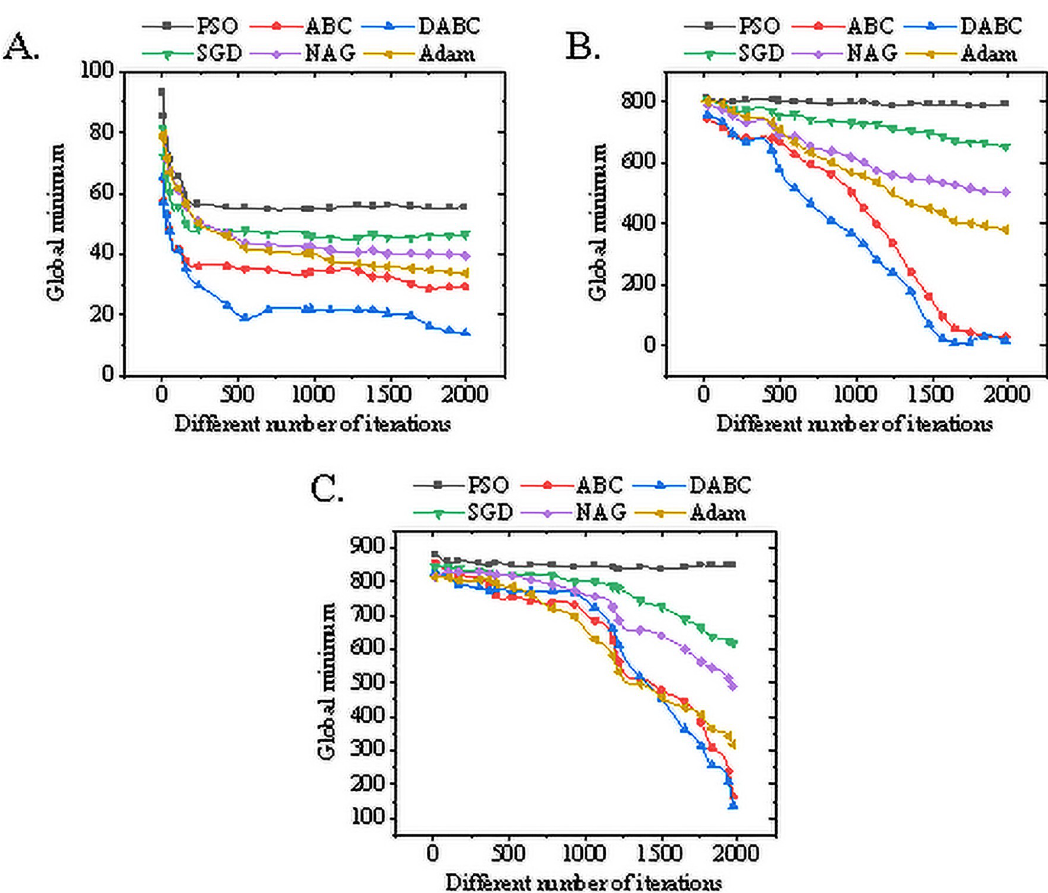
Fig 6. Results of searching performance of different algorithm models on the Rosenbrock function, Ackley function, and Rastrigin function. Note: Fig 6-A shows the results on Rosenbrock function; Fig 6-B represents results on Ackley function; Fig 6-C is presents results on Rastrigin